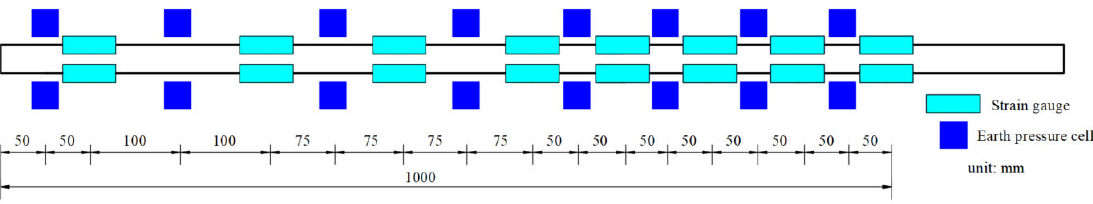
Figure 1. Experimental setup. ( a ) model pile and slope; ( b ) geometric dimension.